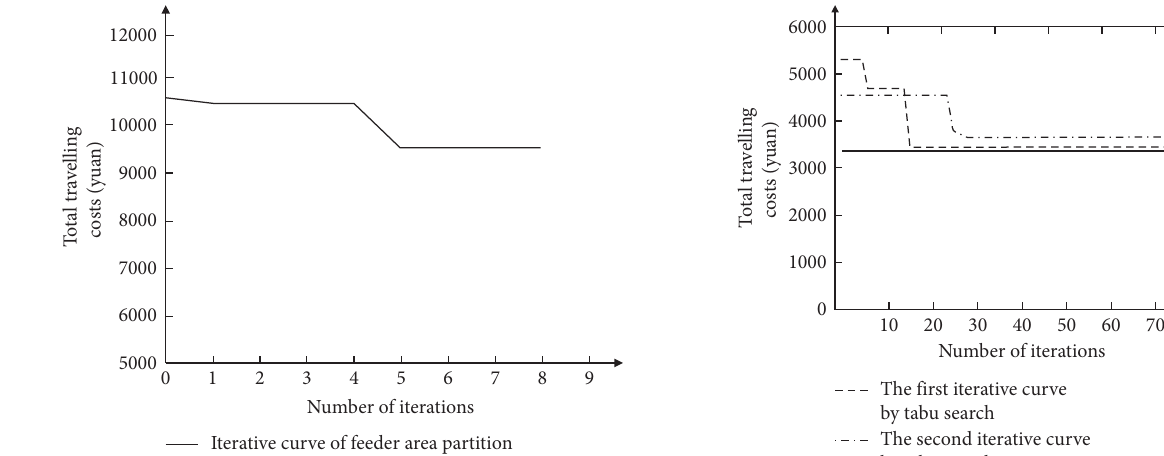
Figure 5: Iterative curve of the feeder area partition.